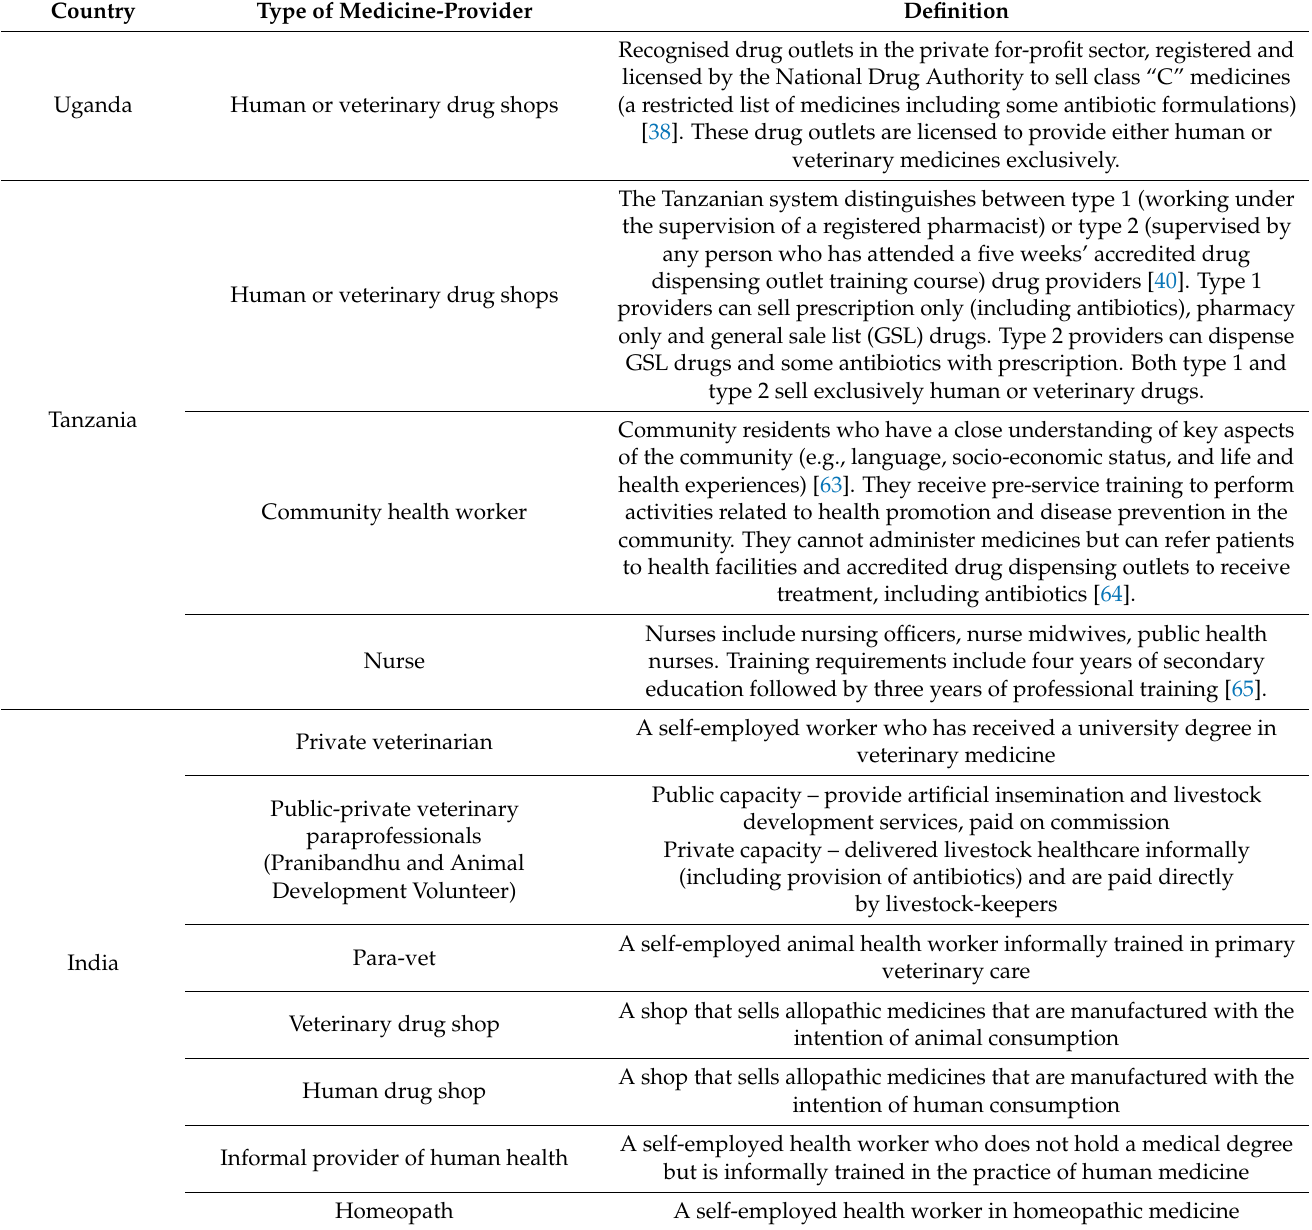
Table 5. Typology and description of the medicine-providers in the different countries whose interviews generated data for the analyses presented in this